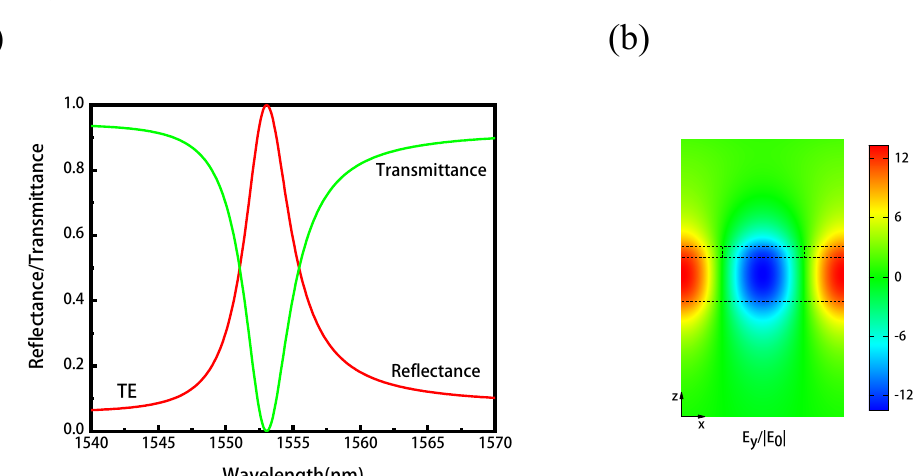
Figure 2. ( a ) The transmission and reflection spectra of the hybrid resonant metasurface. The reflectivity reaches almost 100% around 1553.00 nm. ( b ) The resonant electric field distribution corresponding to the wavelength of 1553.00